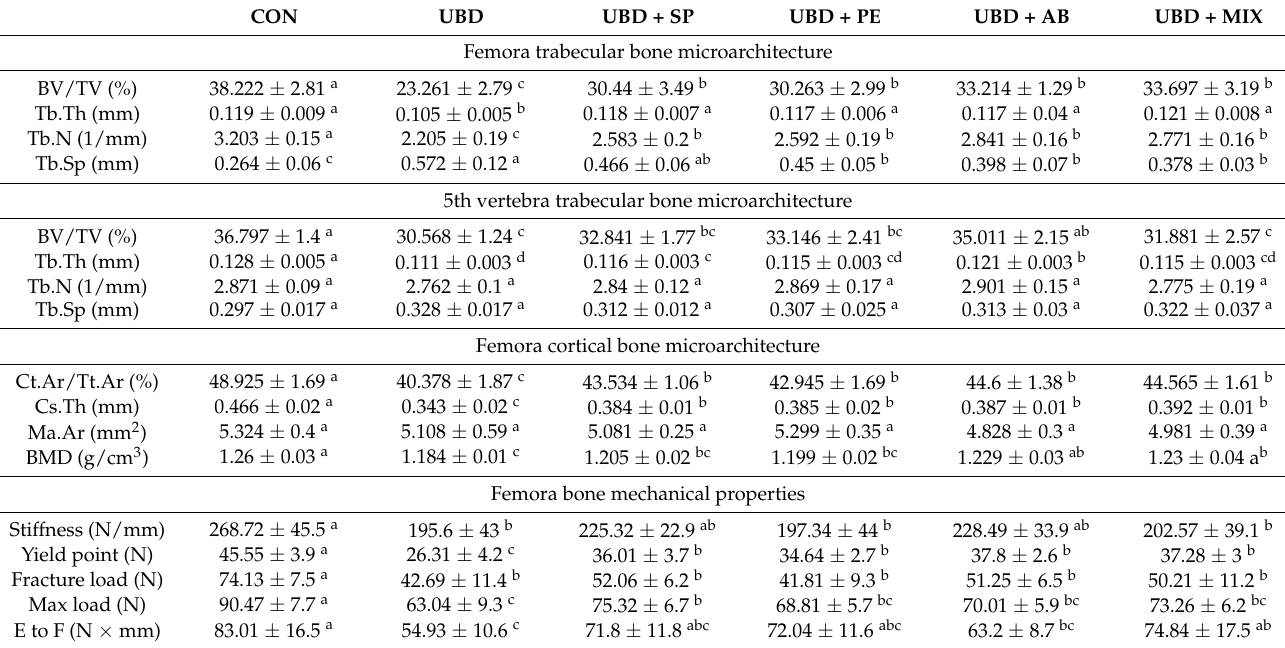
Table 4. Morphometric and mechanic